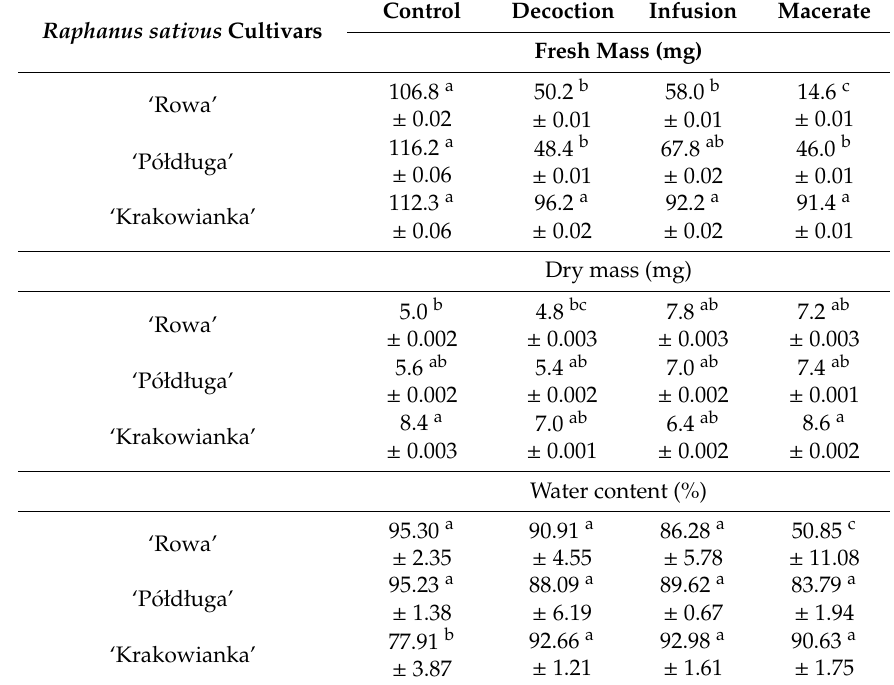
Table 4. Fresh and dry mass and water content of radish seeds Raphanus sativus L. cv. Rowa, P ó łdługa, Krakowianka, treatment of aqueous extracts from Solidago canadensis L.